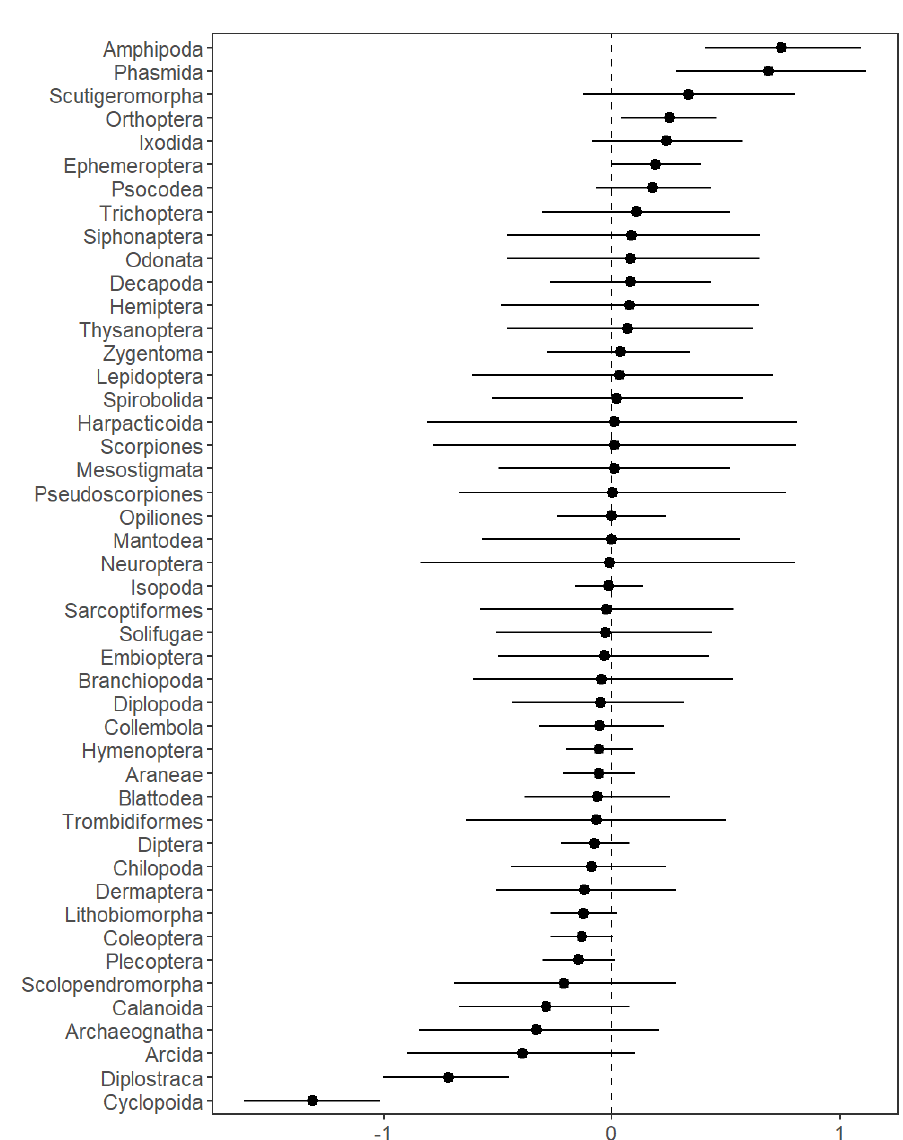
Figure S8: Random effects of taxonomic order on abundance trends. The dots show the mean of the posterior distribution while the error bars show the confidence interval at 95% (quantile 2.5% and